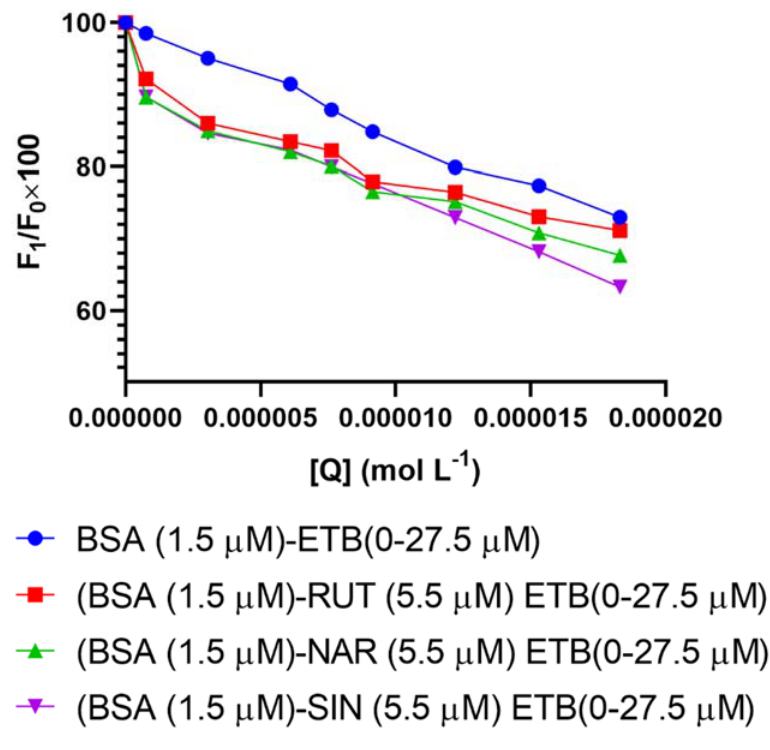
Figure 4. Quenching curves BSA and ETB in presence and absence of flavonoids.